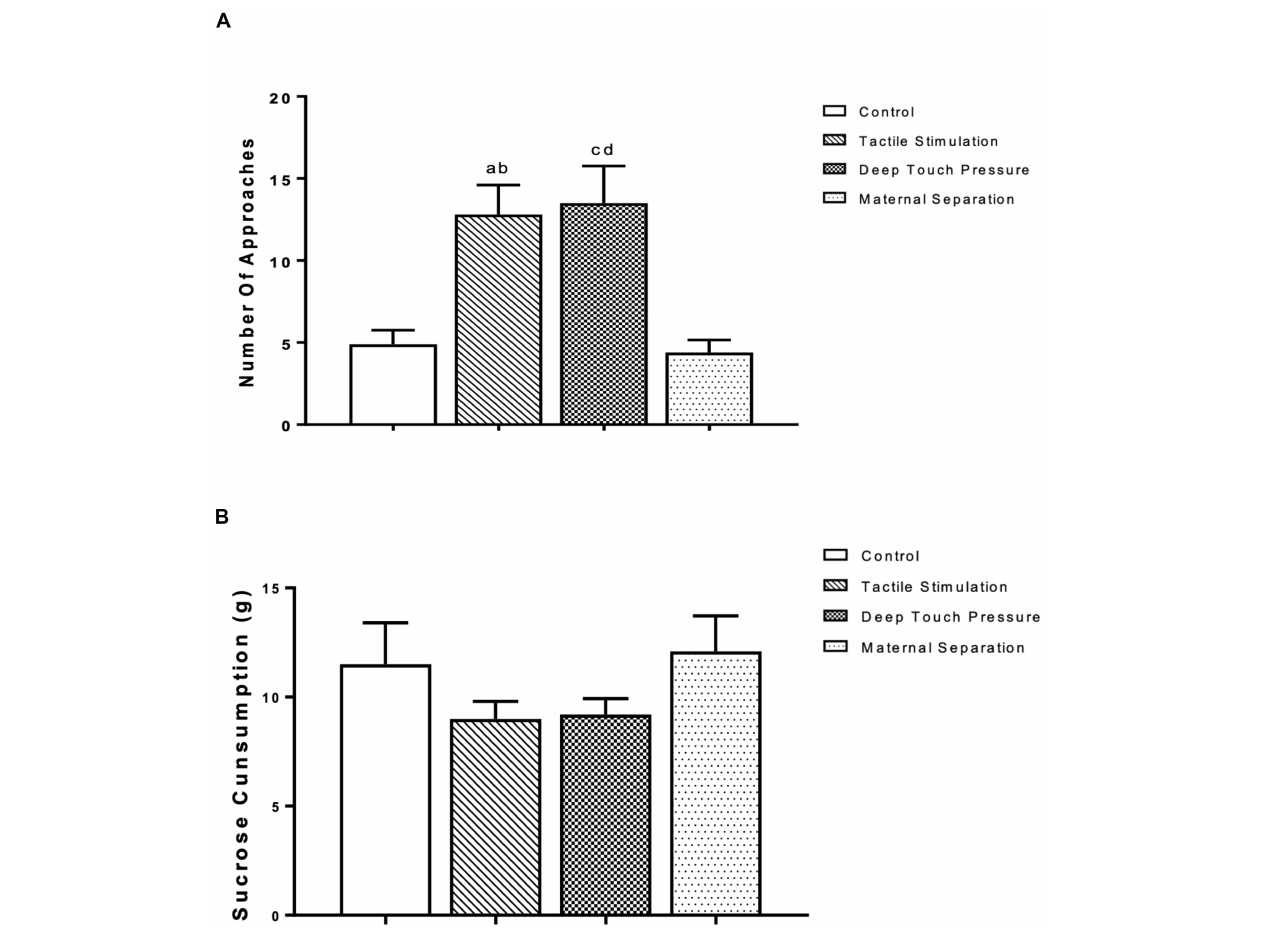
FIGURE 4 | The mean ± SEM ( n = 10 per group) for the amount of sucrose consumed. The influence of TS, DTP, and MS on behavioral parameters in the sucrose consumption test. (A) Number of approaches to the bottle; TS compared to the control ( a p < 0.001) and MS groups ( b p < 0.005); DTP compared to the control ( c p < 0.001) and MS groups ( d p < 0.005). (B) There was no statistically significant difference in the amount of sucrose consumption among groups according to one-way ANOVA measures ( P >